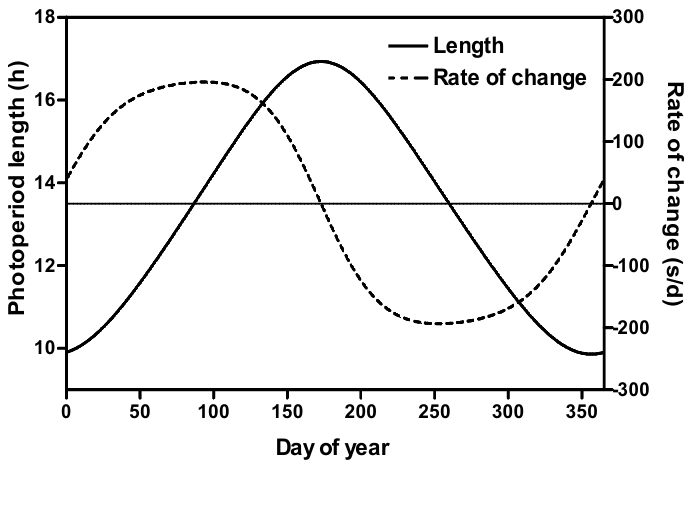
Figure 1. The rate of photoperiod change and the length of the photoperiod as it varied over a year at Ottawa,